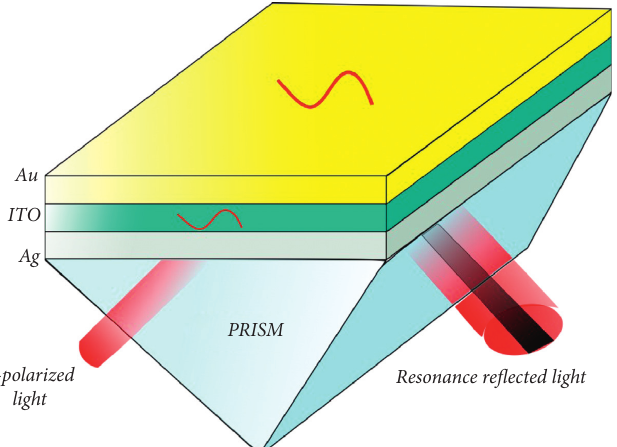
Figure 1: SPR schematic and chip